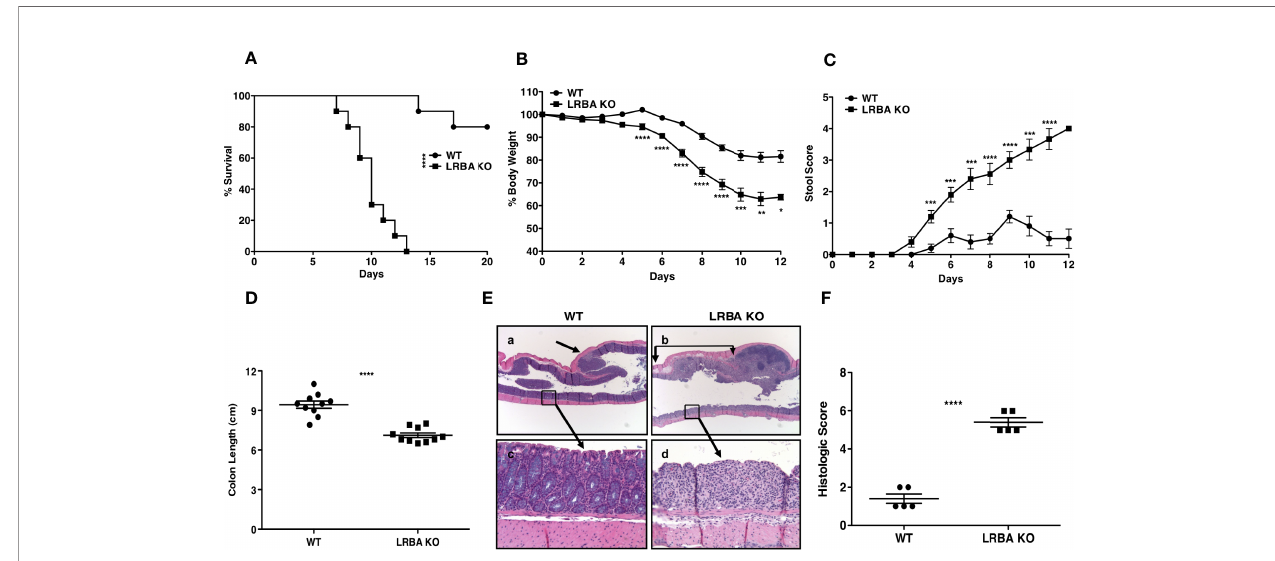
FIGURE 1 | LRBA KO mice are highly susceptible to DSS colitis. WT and LRBA KO mice (129Sv background) were given 3% DSS in drinking water for 7 days. (A) Survival plot, (B) % weight loss, and (C) Stool score based upon rectal bleeding of WT and LRBA KO mice. Mice were euthanized by the end of 7 days for colon length measurement and histologic analysis. (D) Colon length, (E) representative histologic appearance of colitis in WT mice (a, c) with grade 2 colitis comprised of focal, mild epithelial crypt damage and focal <25 PMN/hpf in fi ltration of the lamina propria (a, arrow) but with much of the colonic mucosa without epithelial damage, goblet cell depletion, edema, or PMN in fi ltration (c), as compared to LRBA KO mice (b, d) with grade 5 colitis comprised of regional, marked epithelial erosion, crypt loss, goblet cell depletion (d), submucosal edema (b, between arrows), and moderate to marked >25 PMN/hpf in fi ltration of the lamina propria and submucosa. (F) Histologic scoring of colitis in WT and LRBA KO mice. (A – D) Pooled data from 2 independent experiments with total n = 10. (E, F) Data from 1 of 2 independent experiments are shown with n = 5. *p < 0.05, **p < 0.01, ***p < 0.001, ****p < 0.0001. KO, knockout; DSS, dextran sulfate sodium; WT, wild type; PMN, polymorphonuclear